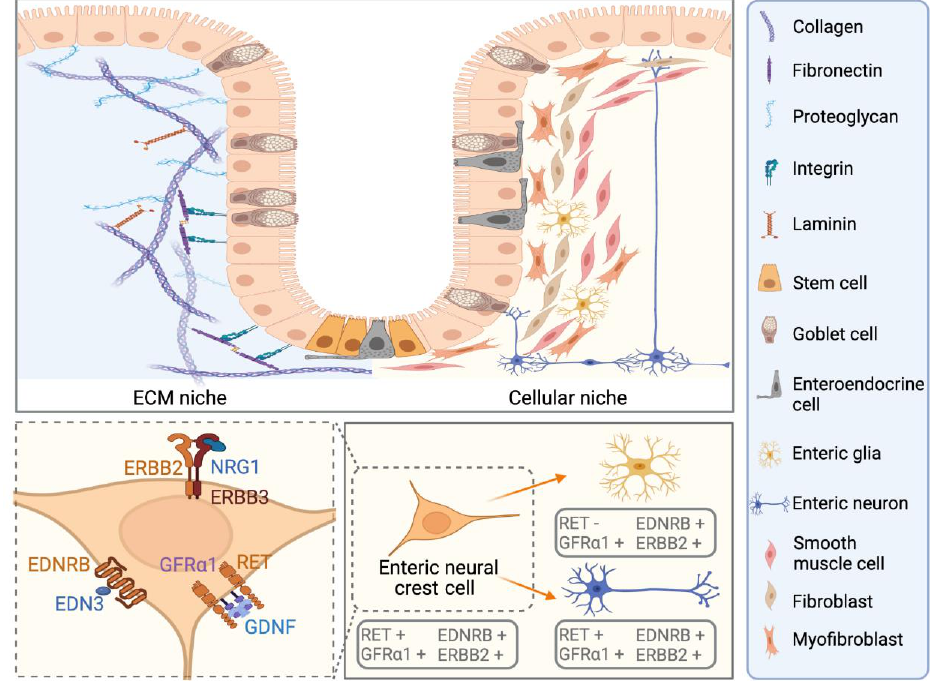
Figure 1. Schematic diagram of enteric neural stem cell niche in human colon. The enteric neural stem cell niche comprises the physical extracellular matrix (ECM) niche and the cellular niche located beneath the epithelial cells (upper panel). The colonic epithelium is a monlayer of polarized columnar cells (including enterocytes, goblet cells, enteroendocrine cells, and intestinal stem cells) organized as repetitive invaginations known as crypts. The ECM niche is a highly structured scaffold that provides physical and biochemical support to the surrounding cells. ECM components contain both the cell surface integrins and secreted proteins from resident cells, such as collagen, fibronectin, laminin, and proteoglycan. The resident cellular niche involves myofibroblast, fibroblast, smooth muscle cells, enteric neurons, and glia. Enteric neurons and glia are differentiated from the ENCCs. GDNF, EDN3, and NRG1 are the key niche factors that are associated with the genetic etiology of Hirschsprung disease. Together with their receptors expressed in ENCCs, including RET, EDNRB, and ERBB2/ERBB3, they form a chemoattractant gradient to mediate the proliferation, migration, and differentiation of the ENCCs (created with